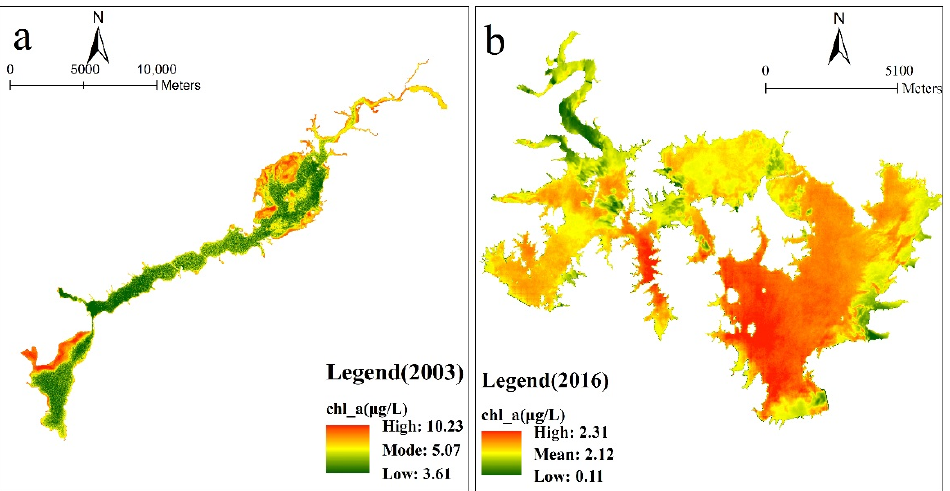
Figure 10. The distribution of chlorophyll-a concentration in Guanting obtained through the estimation model of Miyun Reservoir in 2003 ( a ). The distribution of chlorophyll-a concentration in Miyun obtained through the estimation model of Guanting Reservoir in 2016 ( b ). The color bar indicates the closeness of the concentration value to the mean. Red indicates values exceeding the mean, while green indicates values below the mean.